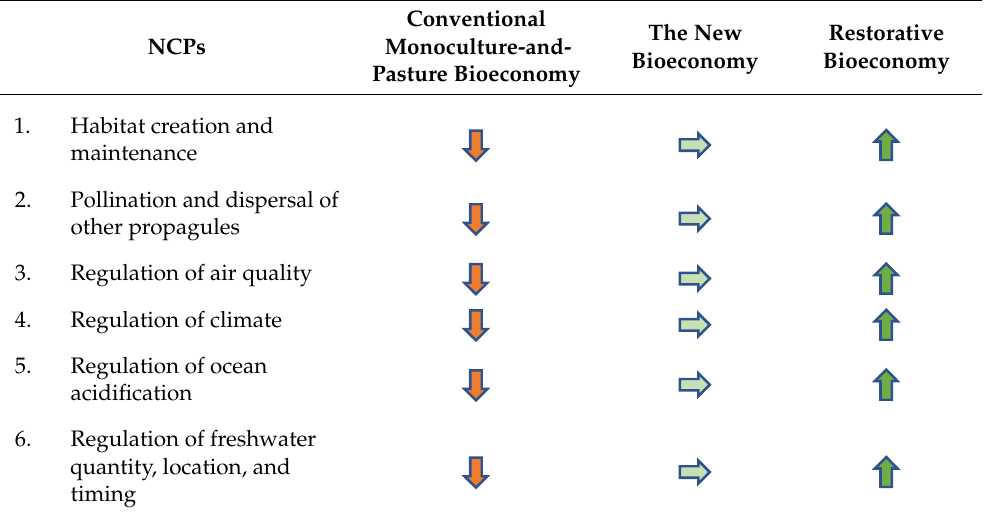
Table 2. The conventional and new types of bioeconomy as contrasting agendas for the Amazon, and the potential for a restorative bioeconomy, in the language of NCPs. The arrows indicate NCPs being generally hampered (arrow down), maintained (arrow forward), or improved (arrow up).